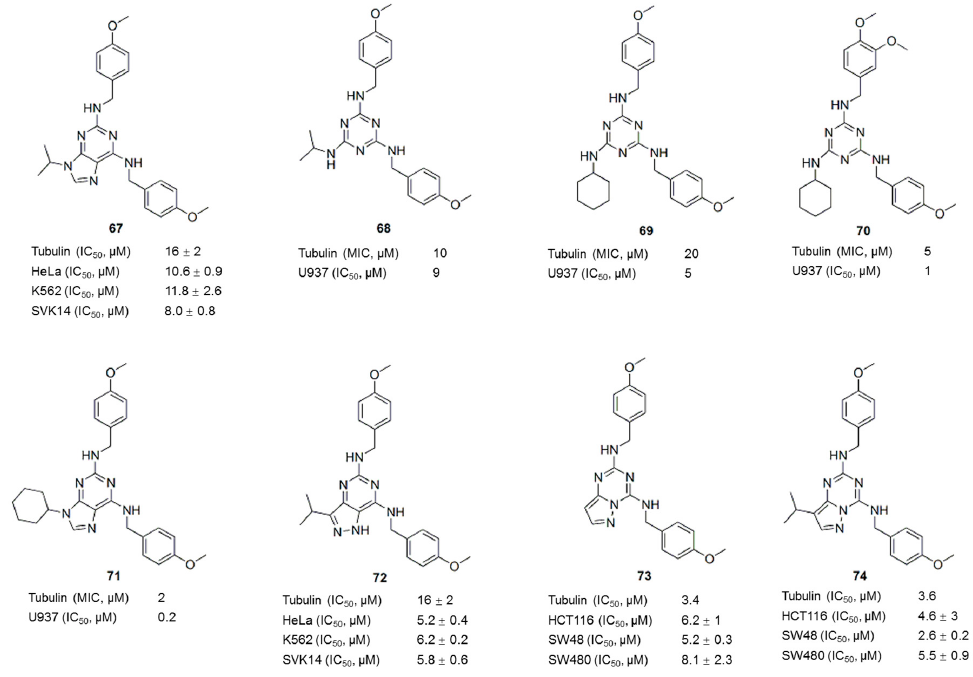
Figure 9. Myoseverin and its derivatives.